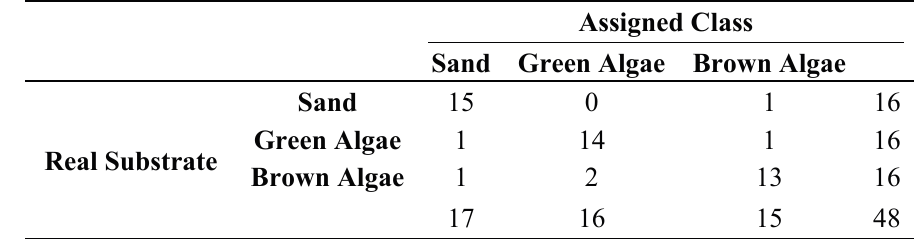
Table 3. Confusion matrix obtained for CRISTAL method using the SAM classification